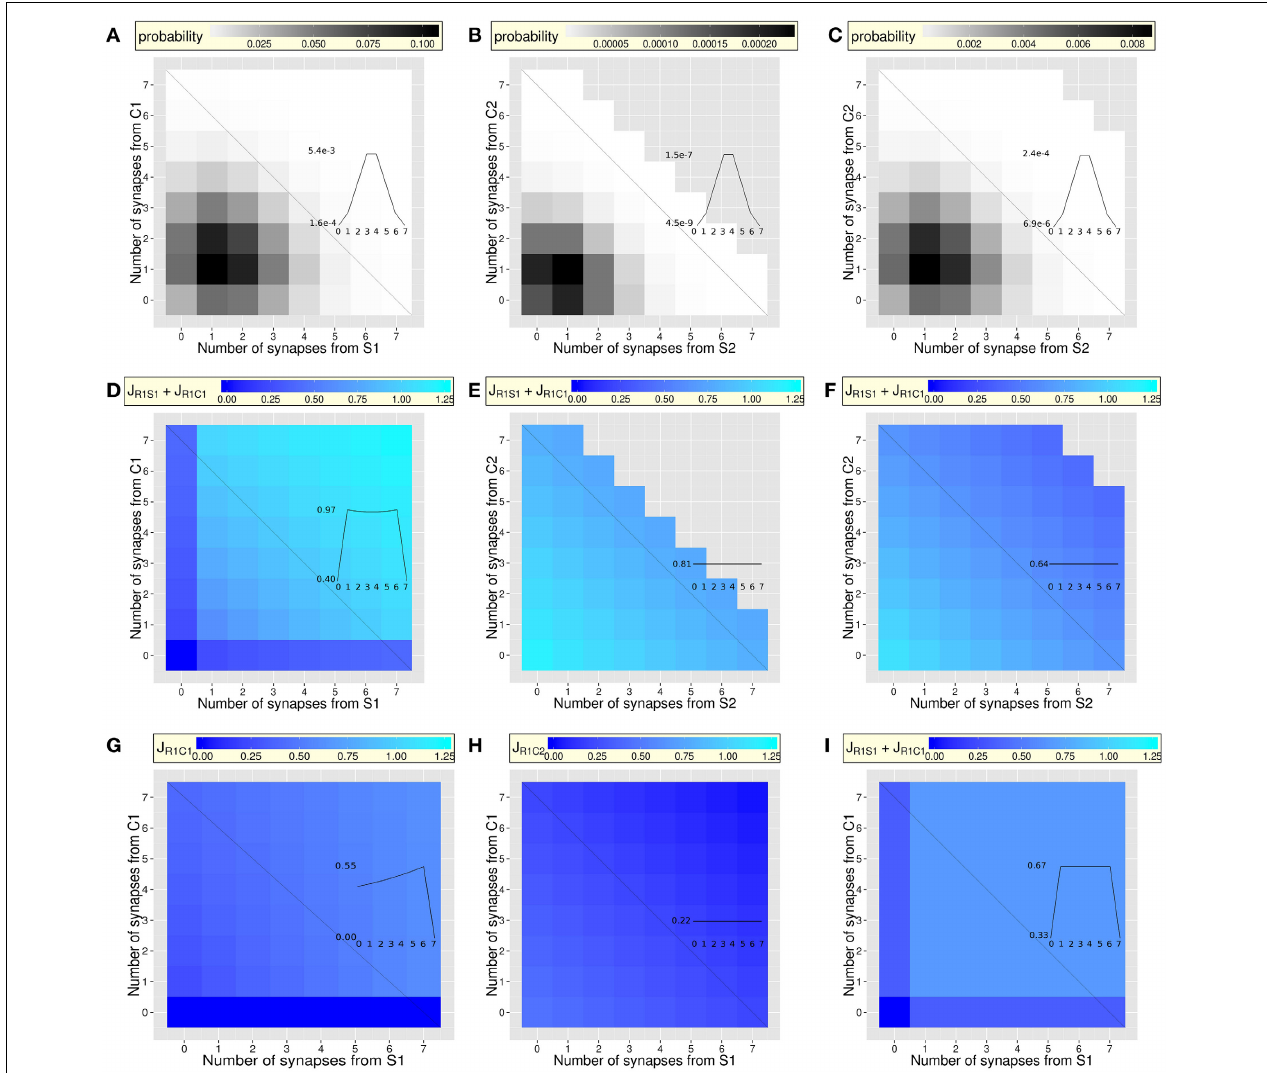
FIGURE 2 | Probability of the types of dendrites (A–C) and synaptic efficacy after inter-synaptic learning (D–I), as a function of the number of synapses from neurons coding for the context and neurons coding for the stimulus (case of dendrites of neurons coding for response R1). For clarity, synapses from NSI-coding neurons are not reported (see Figure 1D for details). Insets focus on the probability or efficacy (y-axe) along the anti-diagonal of each figure, where the number of synapses from the combined items is constant (seven synapses). The x-axe (black anti-diagonal lines) corresponds to the number of synapses from the Stimulus (the inverse number of synapses from the Context). The effects of the increasing number of co-active synapses (from the context and from the stimulus) appear along the diagonal, while the effects of the increasing (decreasing) number of synapses from the stimulus (context) appear on the shape of the curve along the anti-diagonal (insets). Non-flat shapes reveal the effects of IS learning. (A–C) After random connectivity: heterogeneous distribution of the probability of the types of dendrite, defined by the numbers of synapses from pre-synaptic neurons coding for contexts (C1 or C2), stimuli (S1 or S2) and responses (R1 and R2): [C1, S1, C2, S2, R1, R2]. To better display slight variations along the scale, only dendrites occurring with a probability higher than 1.28 × 10 − 9 are displayed (note the different scales between graphs A , B and C ). For a given dendrite, this corresponds to a maximum of seven synapses from pre-synaptic neurons coding for C1 and/or S1. (A) Overall